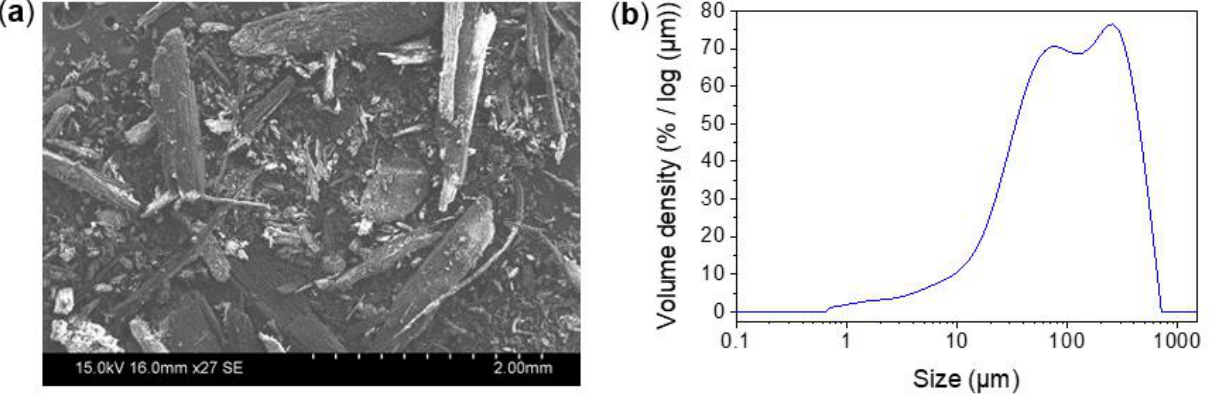
Figure 3. The particle size distribution measurement of the pulverized wood: ( a ) scanning electron microscopy (SEM) and ( b ) laser diffraction particle size analysis.